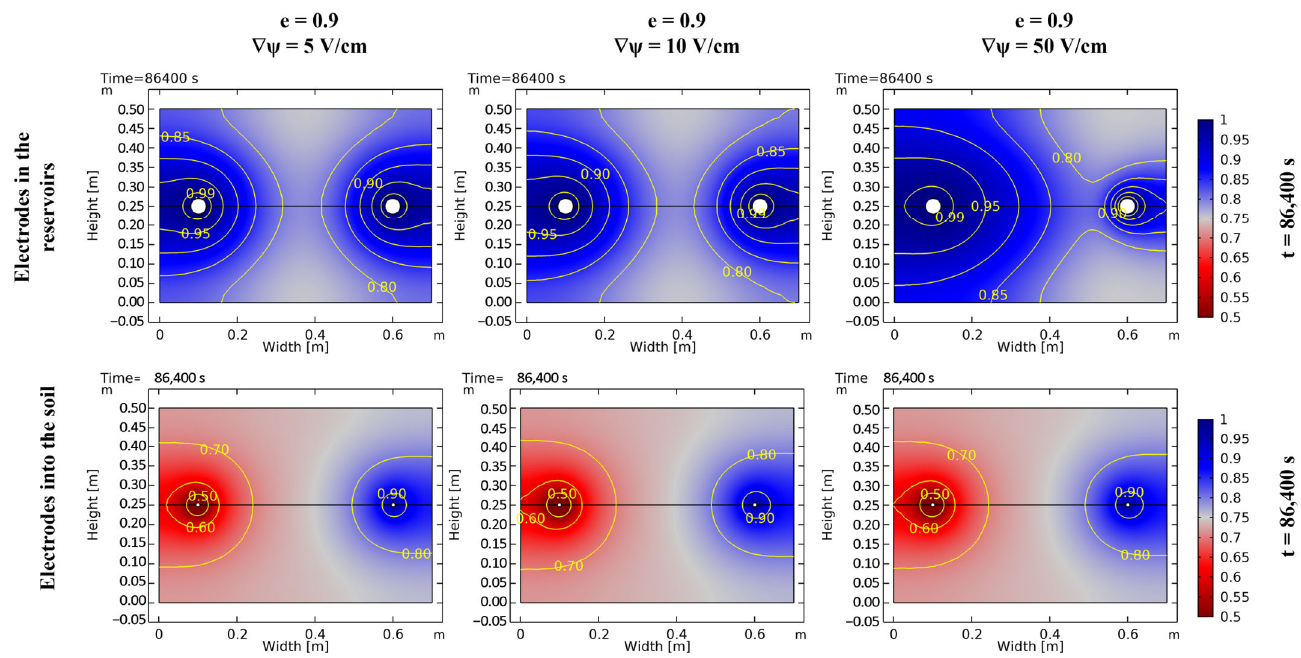
Figure 6. 2D maps of the degree of saturation evaluated at 86,400 s and three electric potential gradients of 5, 10, and 50 Vcm − 1 : 0.7, 0.9, and 1.2 when the electrodes were in the electrolyte reservoirs and inserted into the soil corresponding to the configurations presented in Figure 1a and 1b, respectively. The void ratio of soil was